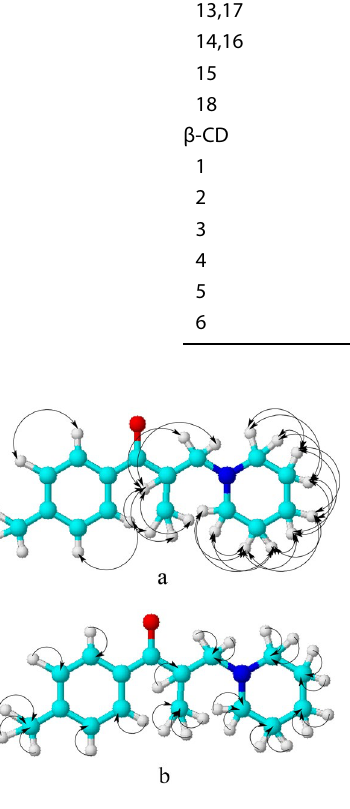
Fig. 5 Correlations in the COZY ( a ) and HMQC ( b ) spectra of 3. Drawn in